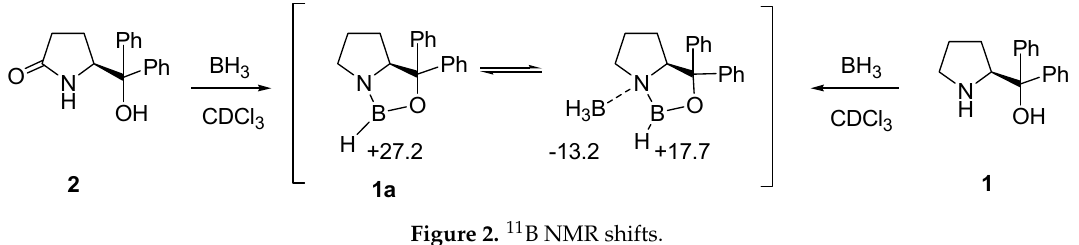
Figure 2. 11 B NMR shifts.